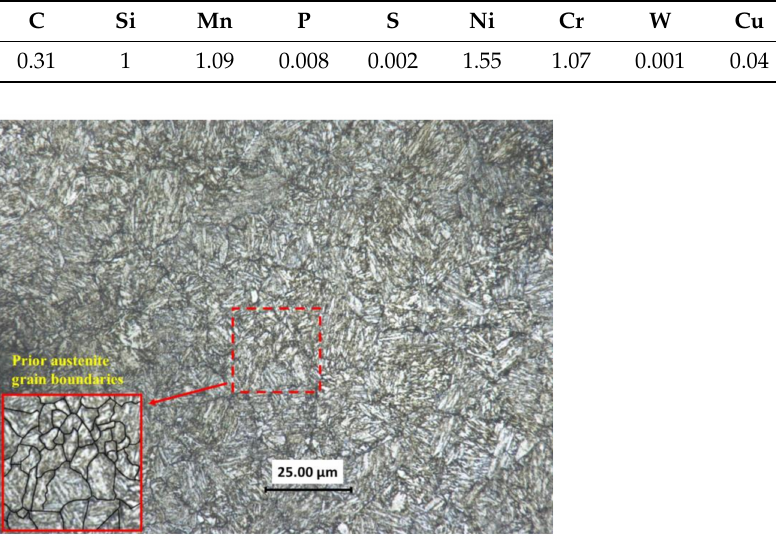
Figure 2. Microstructure of 30CrMnSiNi2a in as received condition.